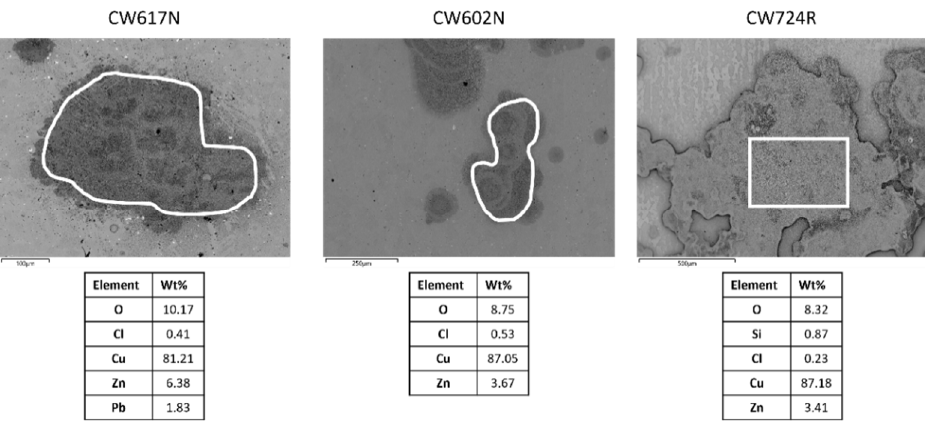
Figure 4. SEM-EDS analyses carried out in correspondence of dark spots formed on brasses after 24 h immersions in SDW solutions at 700 ppm chlorides.